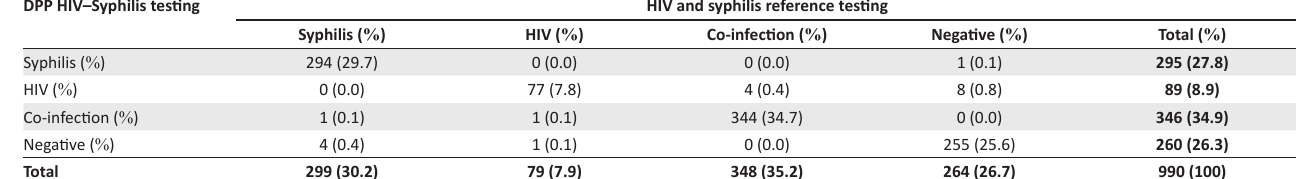
TABLE 3: Comparison of Chembio DPP HIV–Syphilis Assay results and HIV and syphilis reference testing ( N = 990). DPP HIV–Syphilis testing